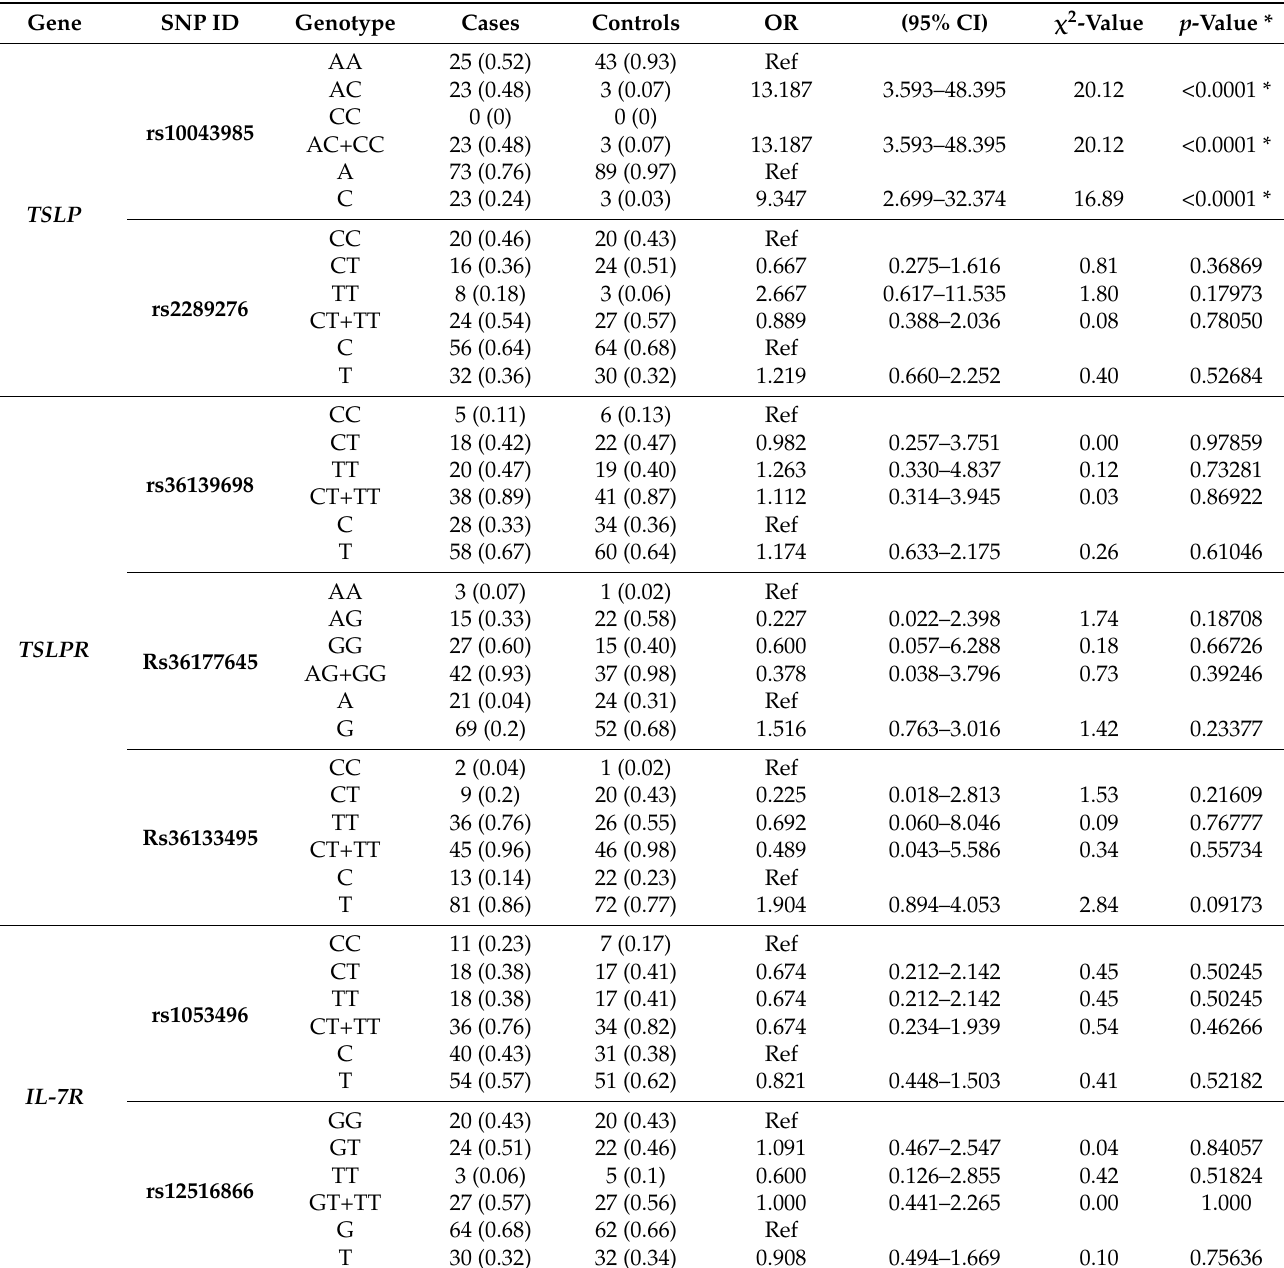
Table 8. Genotype frequencies of TSLP, TSLPR, and IL-7R gene polymorphisms in CRC and controls in female